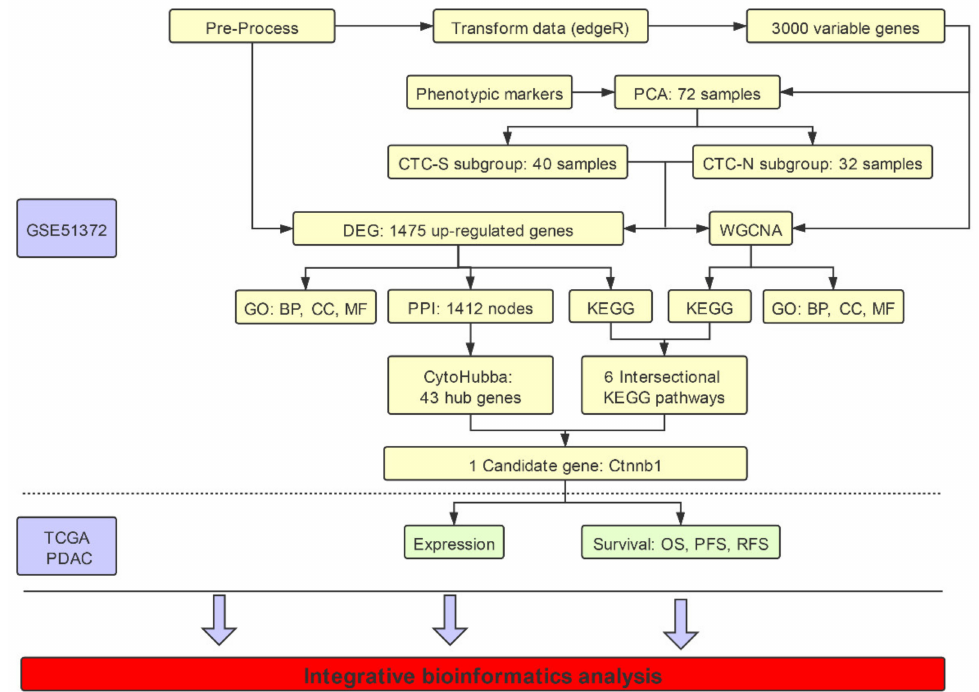
Figure 1. Illustration of the workflow in the integrative bioinformatics analysis. Data set GSE51372 from the Gene Expression Omnibus (GEO) database was used, which contains 75 murine pancreatic CTCs single-cell sequencing datasets. After filtering out three samples with low quality, we further excluded low expression genes, and EdgR transformed the remaining 72 samples. CTCs with stem-like features (CTC-S) and CTC with non-stem-like features (CTC-N) were defined based on the principal component analysis (PCA) of the top 3000 most variable genes. We performed weighted gene co-expression network analysis (WGCNA) on these 3000 genes, while all read counts of 11,931 genes were used to analyze the di ff erentially expressed genes. Further functional enrichment analysis, including the Kyoto Encyclopedia of Genes and Genomes (KEGG) pathways, Gene Ontology (GO) aspects on both di ff erentially expressed genes and WGCNA results was performed. The cytoHubba plugin of Cytoscape 3.5.1 was employed to identify hub genes. Candidate pathways (adherens junction) and genes ( Ctnnb1 ) were identified. The clinical value of KLF4 and CTNNB1 was validated in the TCGA (The Cancer Genome Atlas) pancreatic adenocarcinoma (PDAC) cohort. The workflow was plotted using ProcessOn